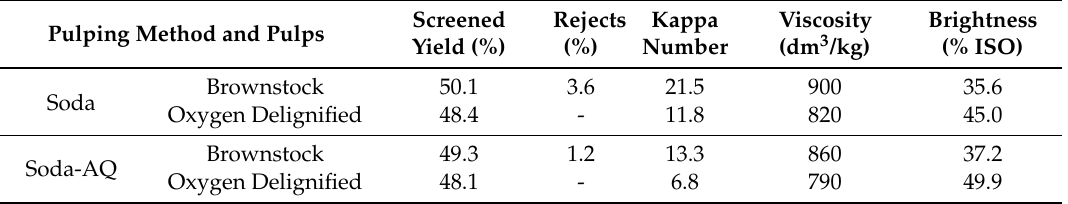
Table 3. Properties of soda and soda-AQ brownstock pulps, and their oxygen delignified pulps [19]. Pulping Method and